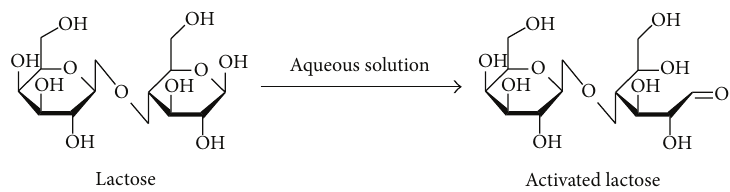
Figure 1: The chemical structure of lactose in aqueous